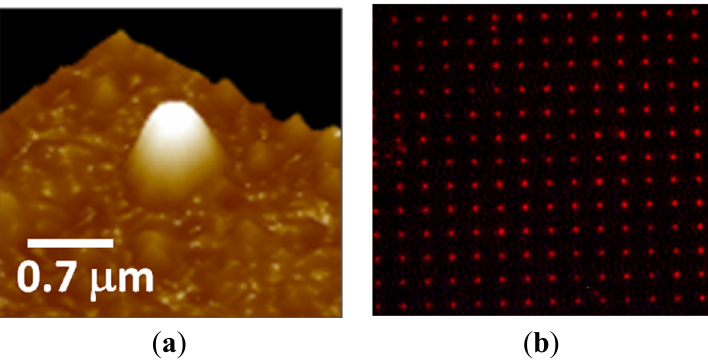
Figure 9. ( a ) AFM image of a single nanoMIP synthesized in an Al nanohole by